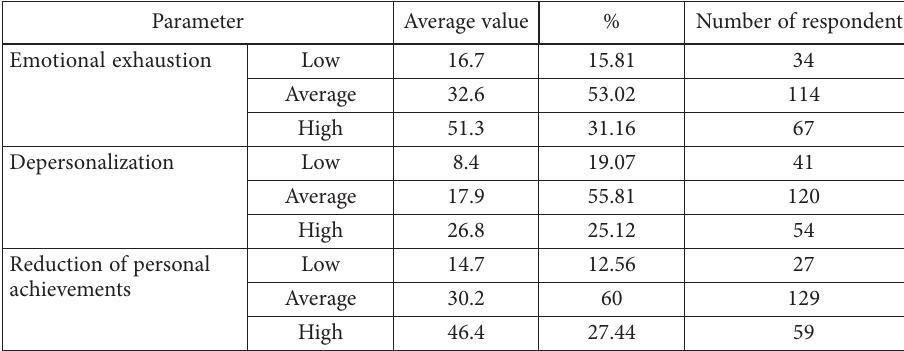
Table 4. Creative and professional stress levels (source: created by